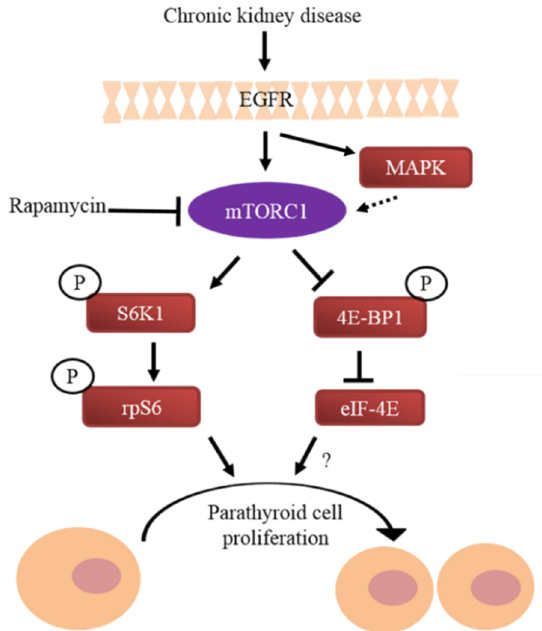
Figure 4. Mammalian target of rapamycin (mTORC1) induces parathyroid cell proliferation in secondary hyperparathyroidism (SHP) through ribosomal protein S6 (rpS6) phosphorylation . The mTORC1 pathway is activated in the parathyroids of rats and mice with CKD-induced SHP. Activated mTORC1 phosphorylates S6 kinase 1 (S6K1) that then phosphorylates rpS6 to induce parathyroid cell proliferation. mTORC1 also disinhibits eukaryotic translation initiation factor-4E (eIF-4E). Rapamycin decreases parathyroid cell proliferation in SHP by inhibiting mTORC1 and by reducing rpS6 activation. High levels of parathyroid epidermal growth factor receptor (EFGR) in SHP activates mTORC1 through mitogen-activated protein kinase (MAPK). The mTORC1 and EGFR pathways may act together to stimulate parathyroid cell proliferation in SHP. P designates protein phosphorylation, the effect of eIF-4E has not been determined (?), the dashed line indicates the suggested effect of MAPK on mTORC1 in the parathyroid cell. Adapted with permission from the Journal of the American Society of Nephrology [88] .